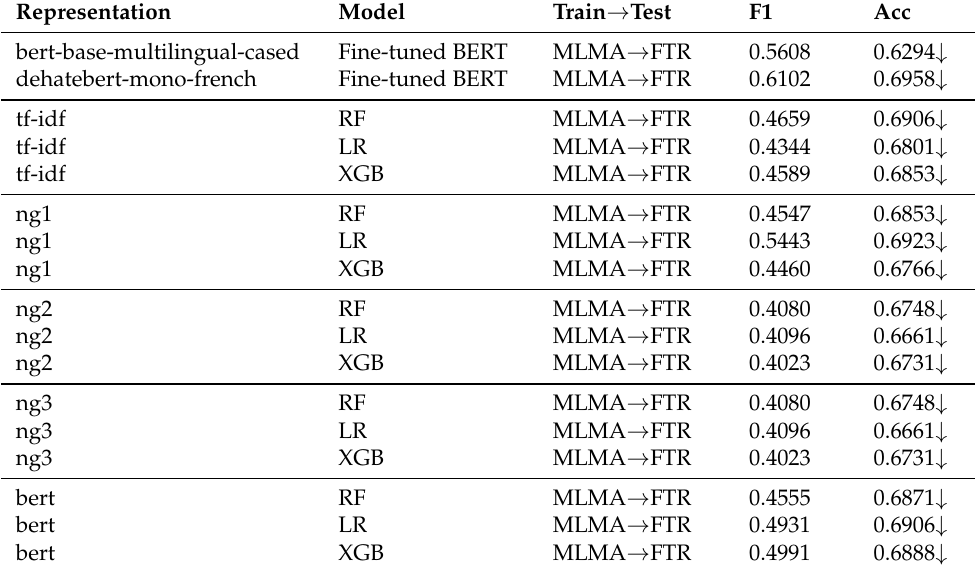
Table 7. Cross-domain evaluation results (accuracy and